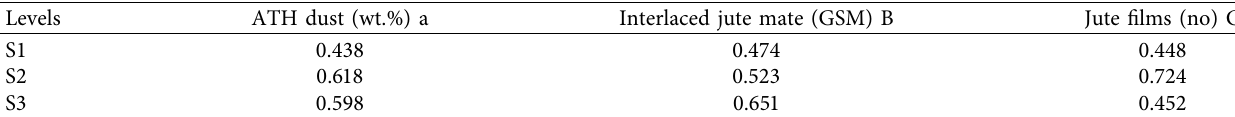
Table 6: Response table for GRS.